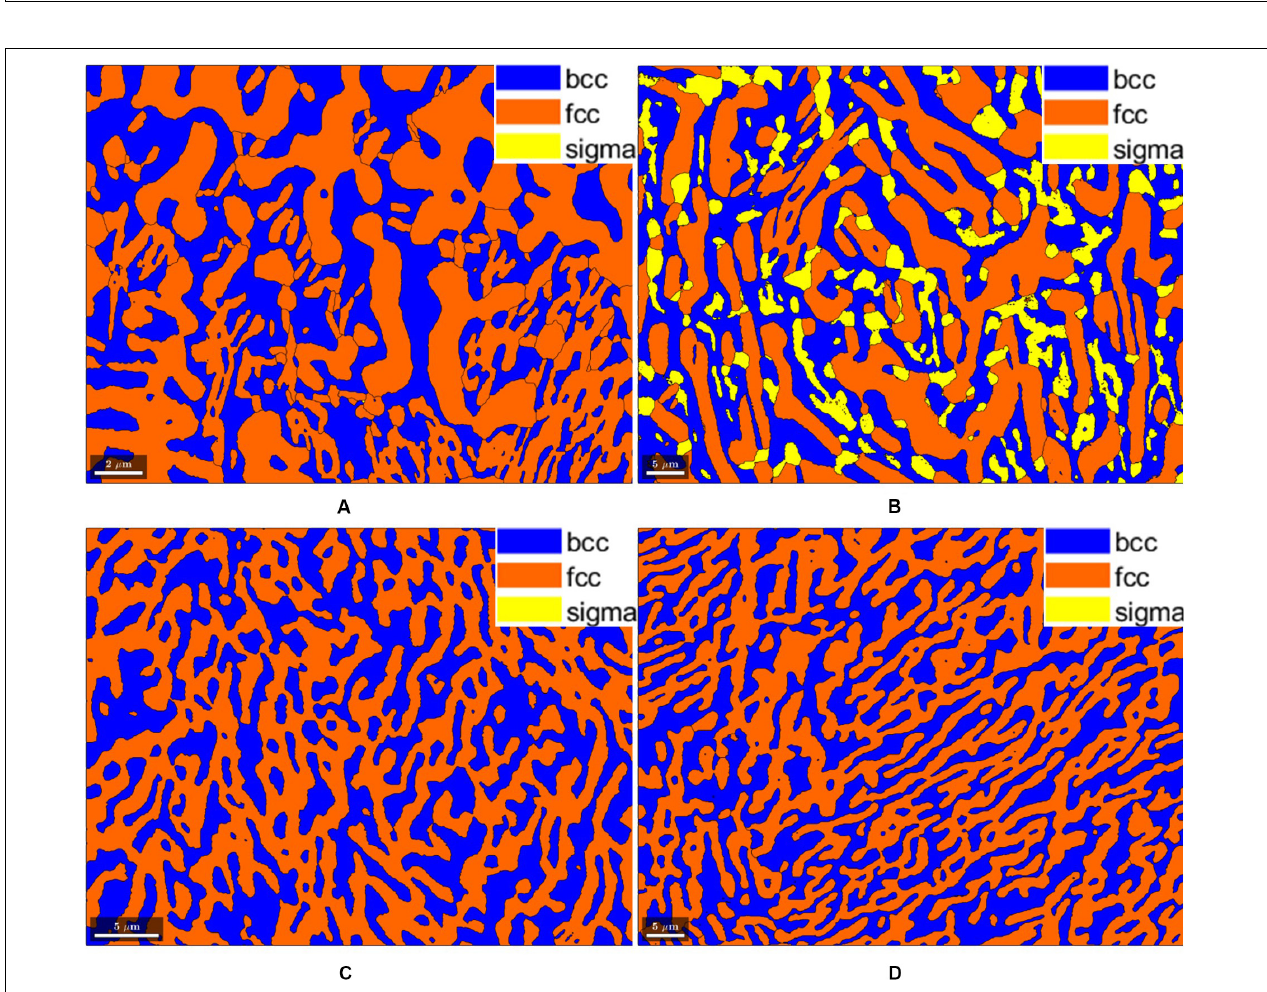
FIGURE 4 | EBSD map of samples (A) Mo 0 in as-cast condition, (B) Mo 2 after annealing at 950 ◦ C/6 h, (C) after annealing at 1100 ◦ C/1 h, and (D) 1100 ◦ C/3 h. Sigma phase is only present in Mo 2 950 ◦ C/6 h.